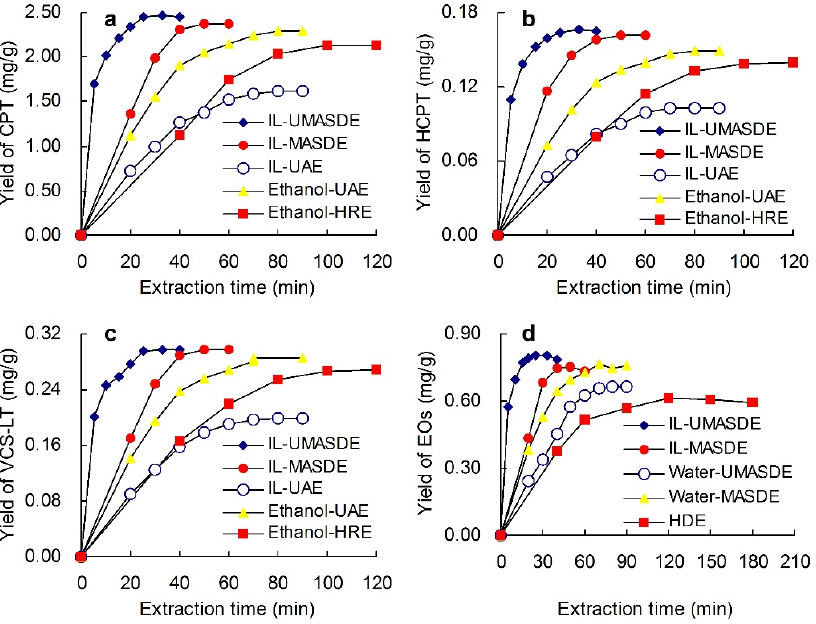
Figure 7. Comparison of different methods for extraction of CPT, HCPT, VCS ‐ LT, and EOs from C. acuminata fruits. Effect of extraction time on Yield CPT ( a ) HCPT ( b ) BCS ‐ LT ( c ) and Eos ( d ).